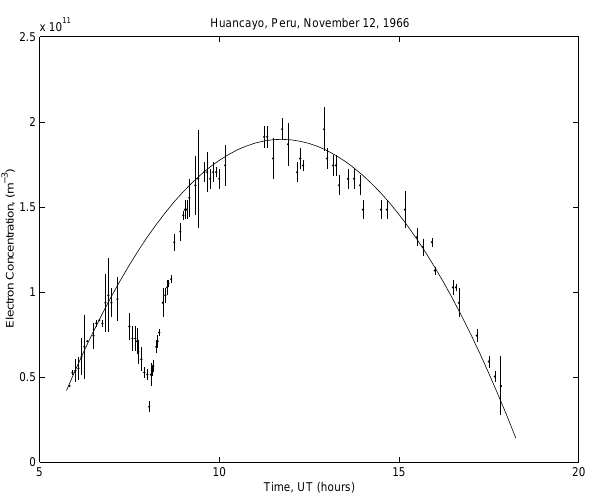
Fig. A7. The variation of the E region peak electron concentra- tion with time during the eclipse of 11 July 1991 at Maui, Hawaii (points). The control day is represented by a polynomial fit to the data from an adjacent day (solid line).